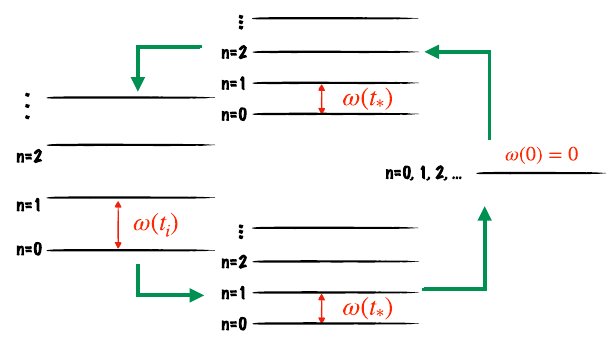
Fig. 1 Schematic representation of the quantum adiabatic cycle under study. The system is prepared in the ground state of the Hamiltonian ( n = 0) with a regular, well separated, spectrum at the initial time − t i . Each excited state is labeled by a growing integer n . Then, the Hamiltonian is dynamically driven in such a way to reduce the spectral gap of the system ω ( t * ) ≪ ω ( − t i ) (i.e. followong the lower green arrows), until the instantaneous spectrum becomes fully degenerate ω ( t = 0) ≃ 0 (on the right in the picture). Finally, the drive protocol is inverted and the initial Hamiltonian is restored (following the upper green